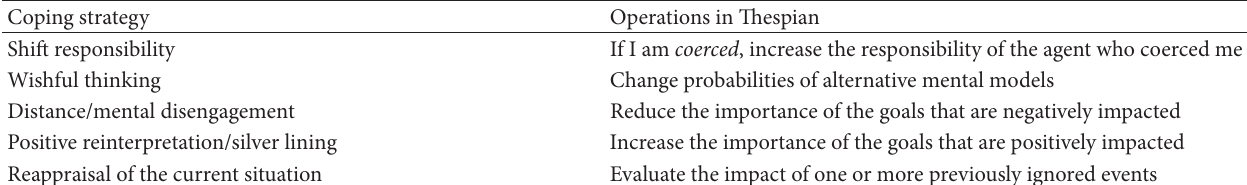
Table 1: Operations for emotion-focused